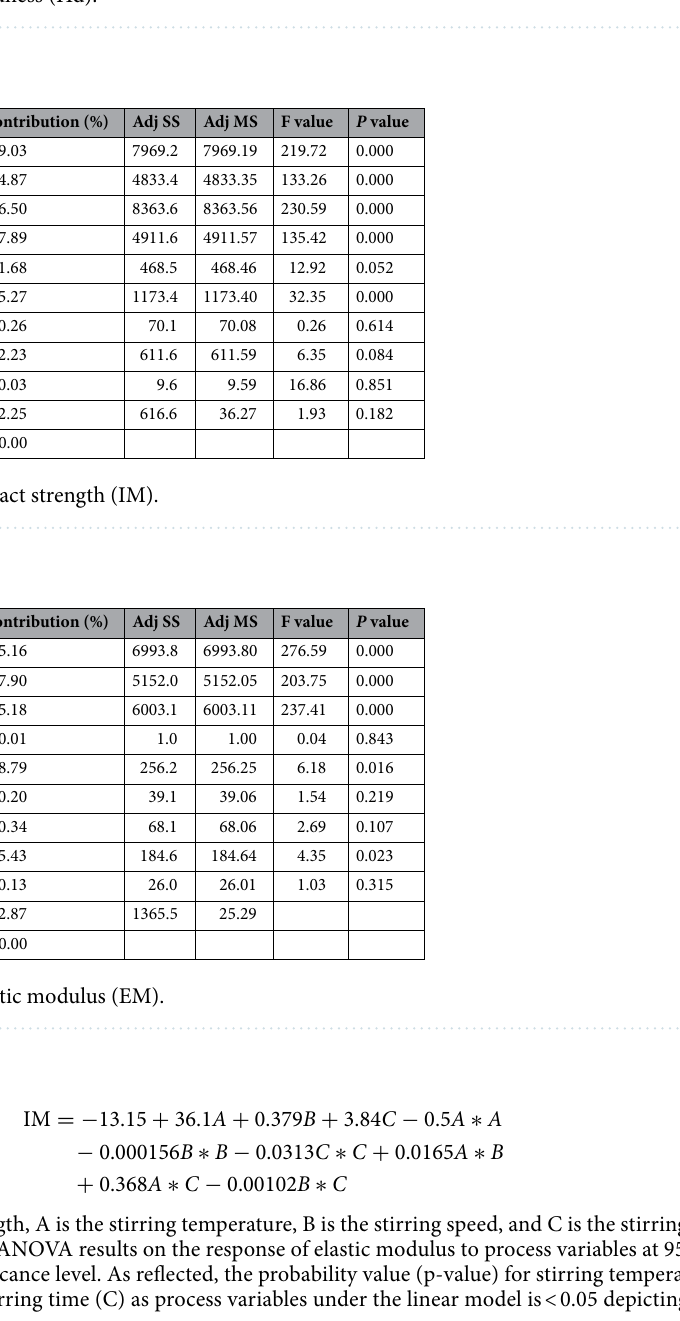
Table 6. ANOVA on hardness (Hd).